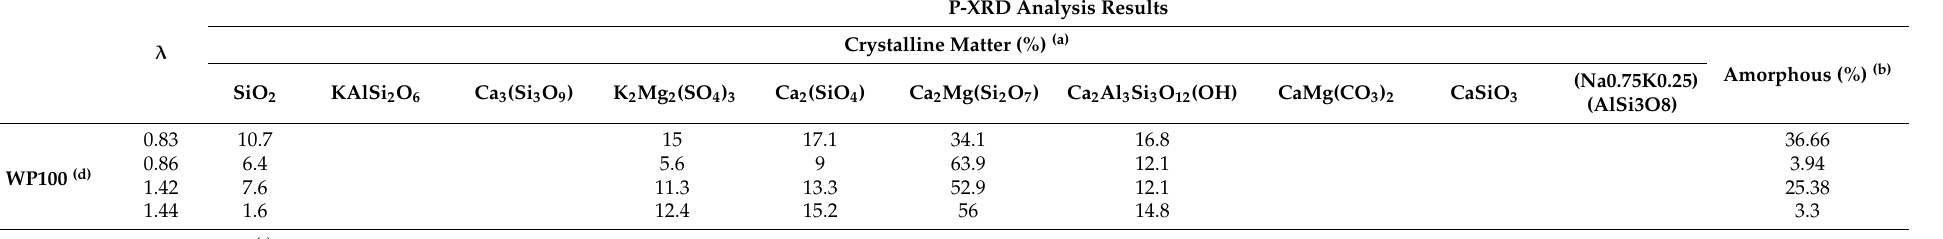
Table 5. Fraction S2/3 composition (combustion test